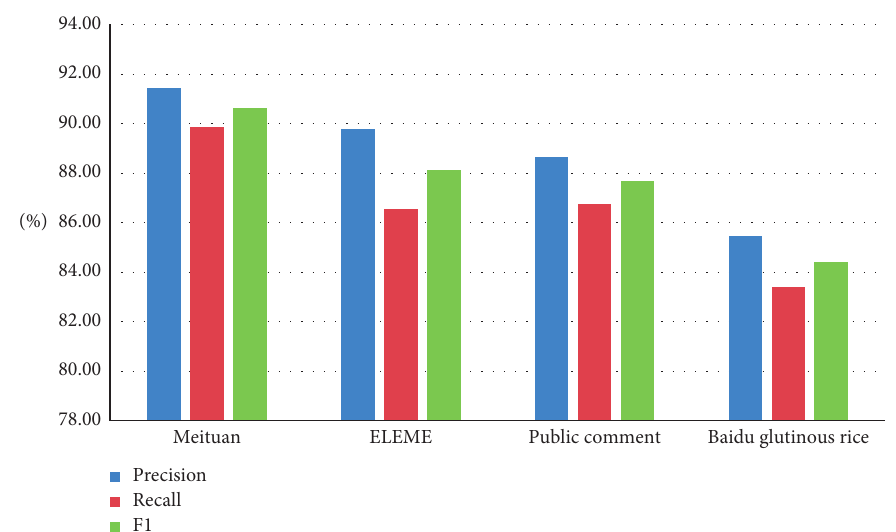
Figure 17: Comparison of food and beverage recommendation performance of tourism